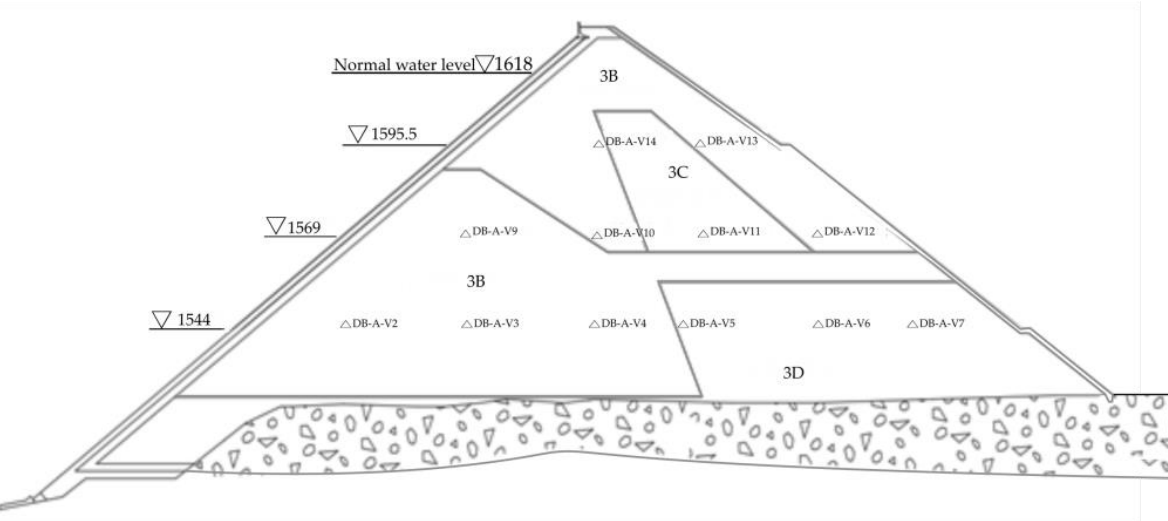
Figure 2. The layout of monitoring points of Liyuan dam.